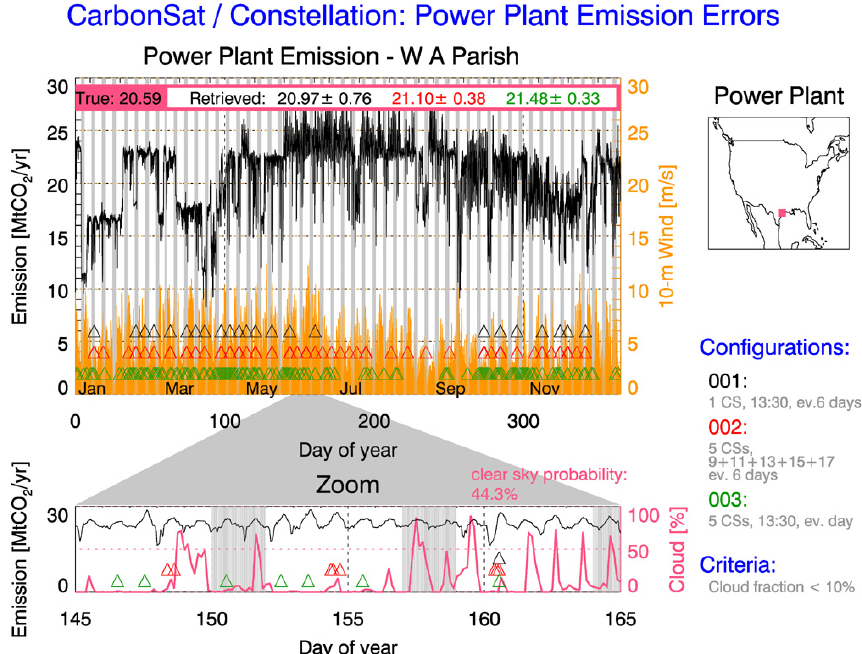
Fig. 8. Same as Fig. 6 for the power plant W. A. Parish in